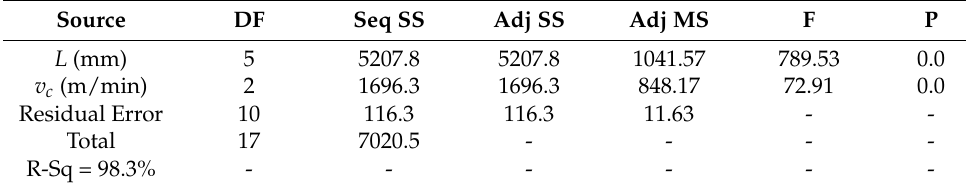
Table 10. ANOVA statistical analysis for Fc